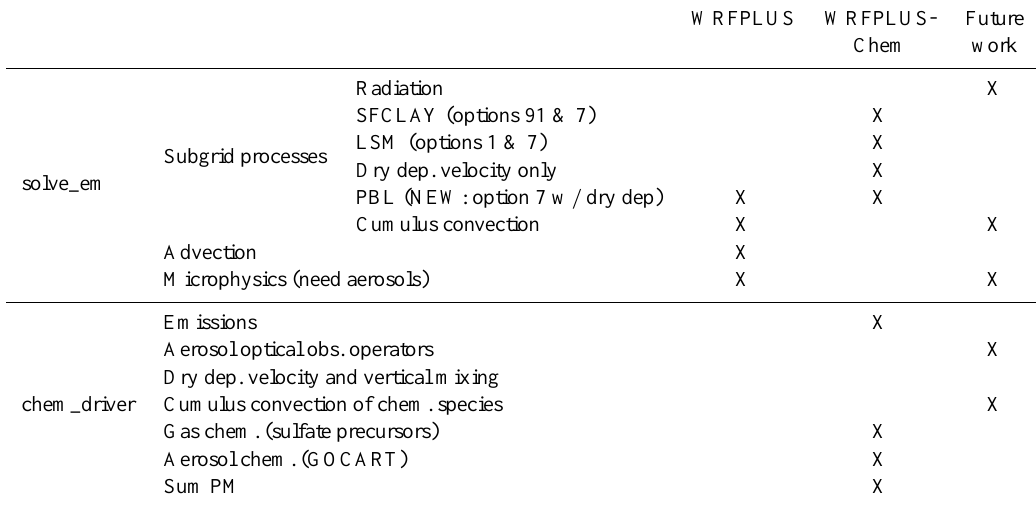
Table 1. Status of AD/TL development for WRF-Chem